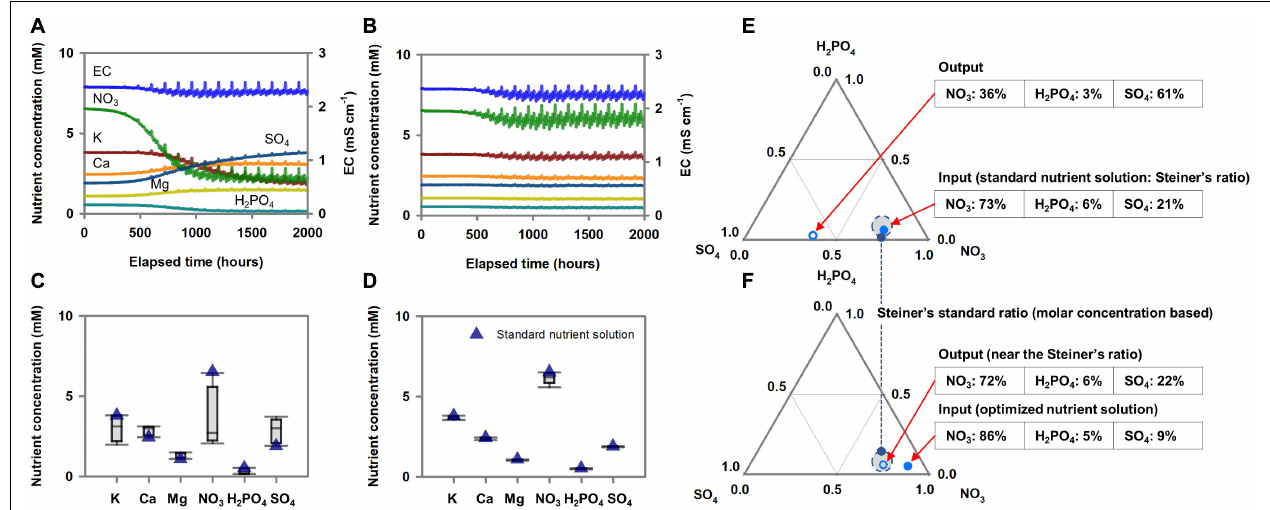
FIGURE 6 | Optimization results of a standard nutrient solution for acquiring the reproducible and least deviating root-zone nutrient dynamics from the initial nutrient condition under the EC+volume-based nutrient dosing method. (A) Changes in root-zone nutrients concentration when the nutrient dosing was performed as a nutrient solution with a conventional standard nutrient solution. (B) Changes in root-zone nutrients concentration when the nutrient dosing was performed as an optimized nutrient solution. (C) Box-plot of the nutrient distribution during the nutrient dosing simulation with a nutrient solution with a conventional standard nutrient concentration. (D) Box-plot of the nutrient distribution during the nutrient dosing simulation with an optimized nutrient solution. (E) The percentage molar ratio’s final simulation output under the nutrient dosing condition of a conventional standard nutrient ratio input (Steiner’s ratio). (F) The percentage molar ratio’s final simulation output under the nutrient dosing condition of an optimized nutrient ratio input.